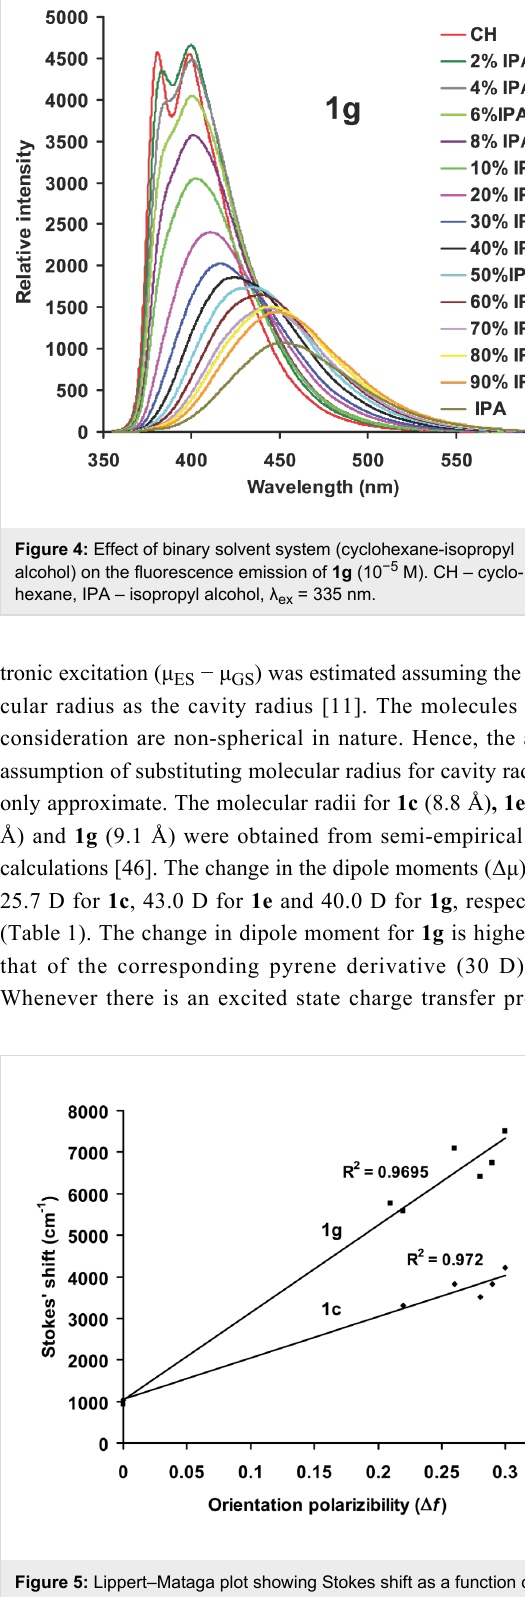
Figure 5: Lippert–Mataga plot showing Stokes shift as a function of solvent orientation polarizibility ( Δ f ).